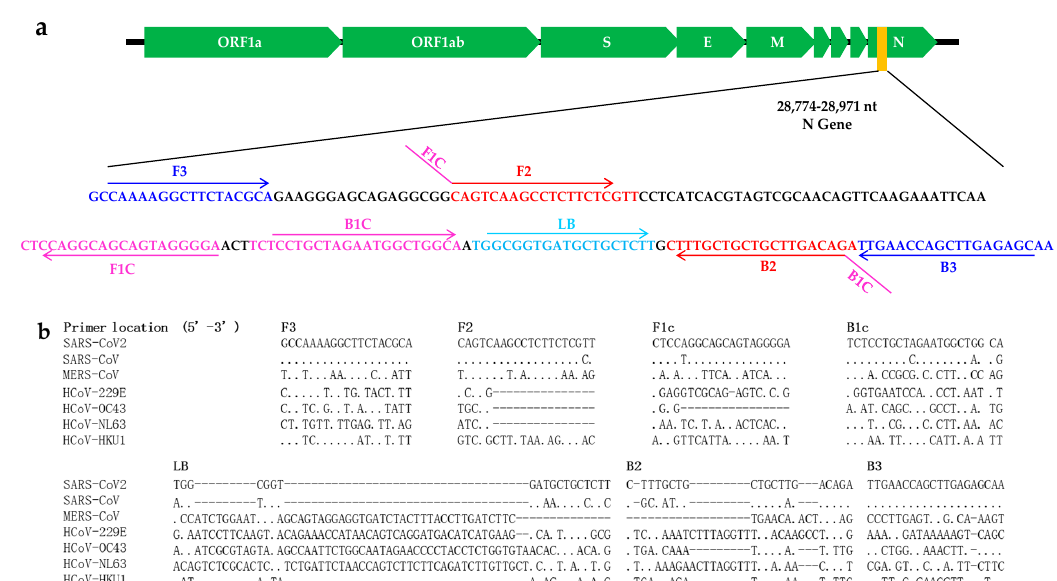
Figure 1. Primer information. ( a ) Location of the primers in SARS-CoV-2 genome; ( b ) Sequence comparison among seven human coronaviruses (SARS-CoV-2, SARS-CoV, MERS-CoV, OC43, HKU1, NL63 and 229E).